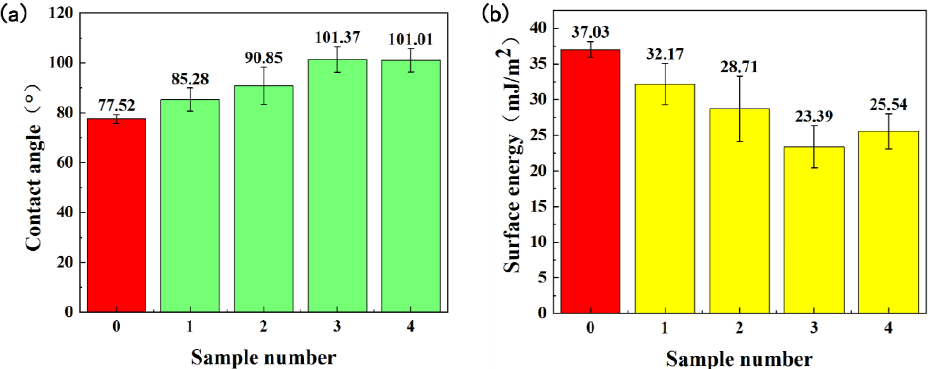
Figure 11. Measured ( a ) contact angle and ( b ) surface energy of LCC specimens No. 0–4 with various Ni60/TC4 mass ratios.